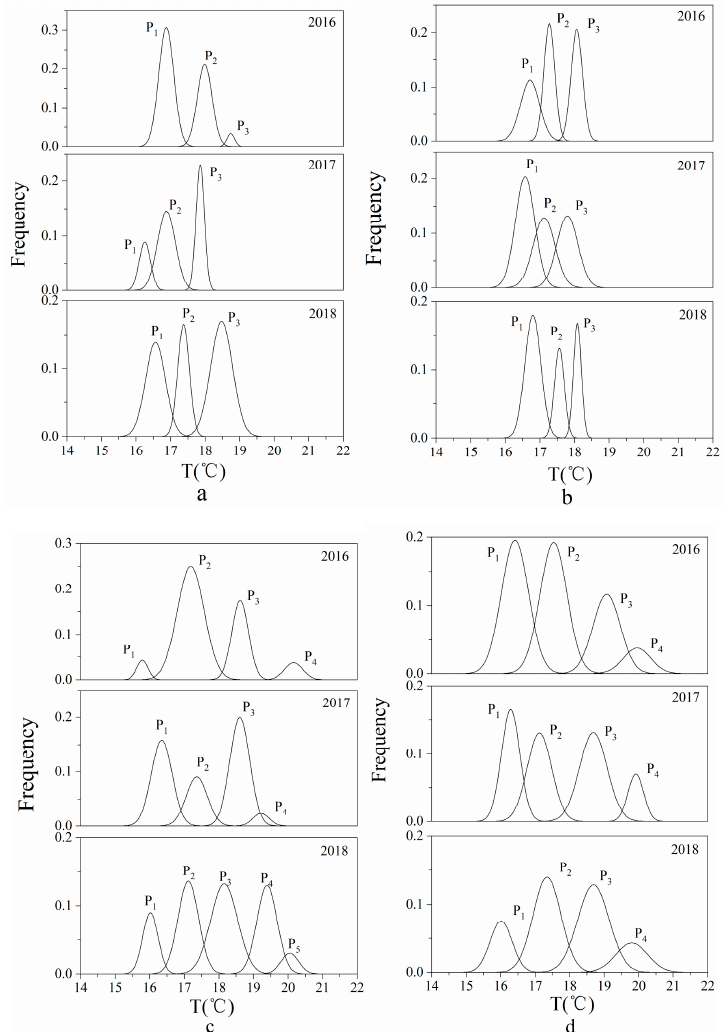
Figure 9. Frequency distribution of the water temperature in the four major springs. ( a ) Baotu Spring; ( b ) Heihu Spring; ( c ) Tanxi Spring; ( d ) Zhenzhu Spring.